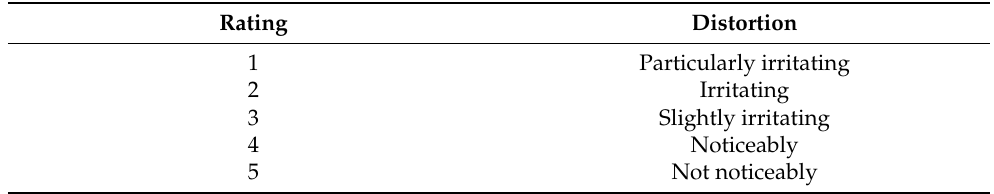
Table 21. Image distortion ratings.